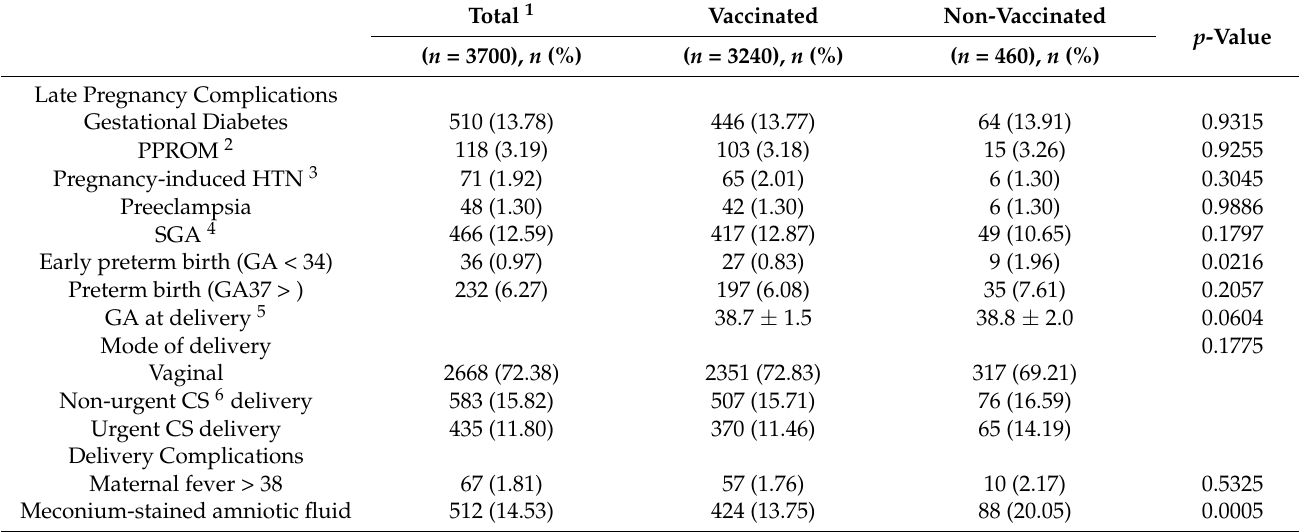
Table 2. Obstetric Outcomes.